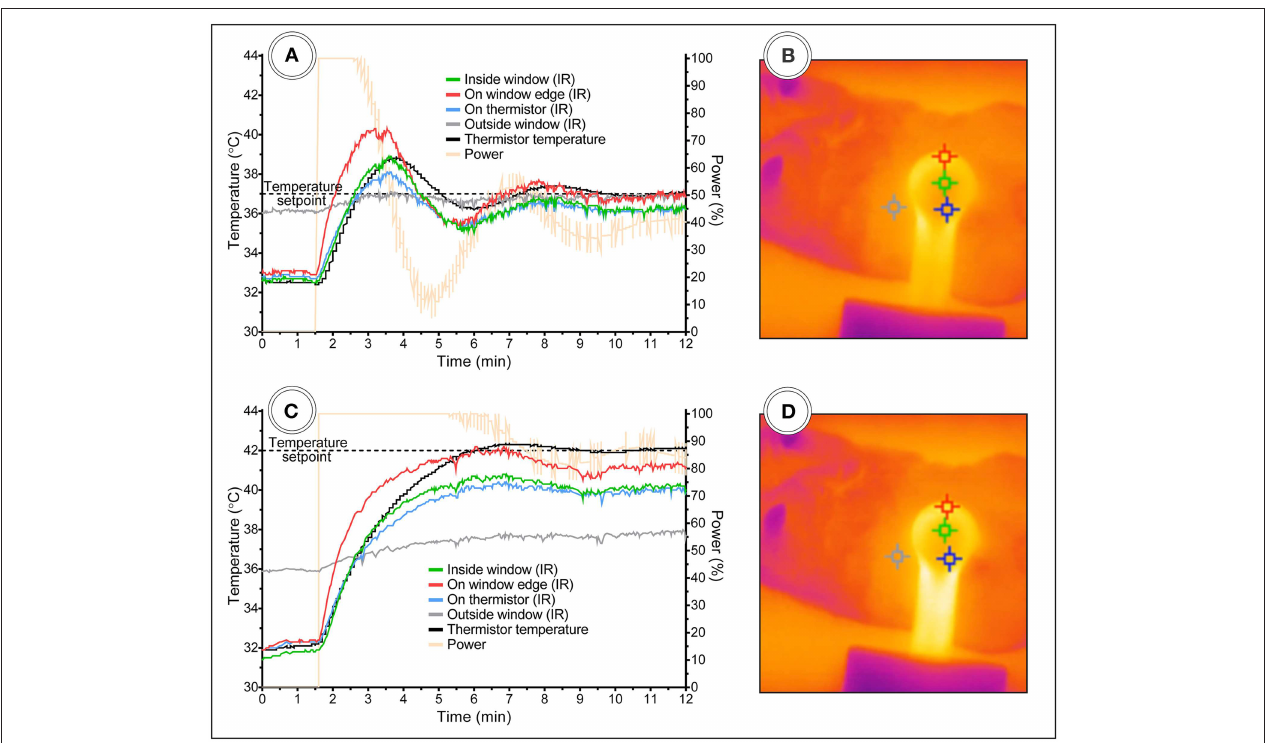
FIGURE 6 | Vacuum window temperature control dynamics in anesthetized mice with skin flap attached to window. Temperature setpoint at (A) 37 ◦ C and (C) 42 ◦ C. (B,D) Shows the corresponding IR images with temperature measurement points.